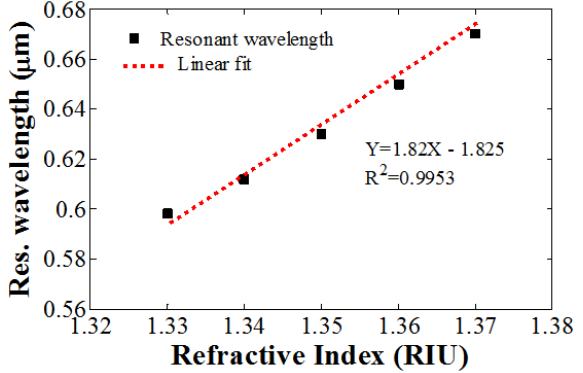
Figure 7. Linear fitting of the resonance wavelength as a function of analyte RI for Λ = 2 µ m, d c = d 1 = 0.2 Λ , d = 0.4 Λ , and t g = 40